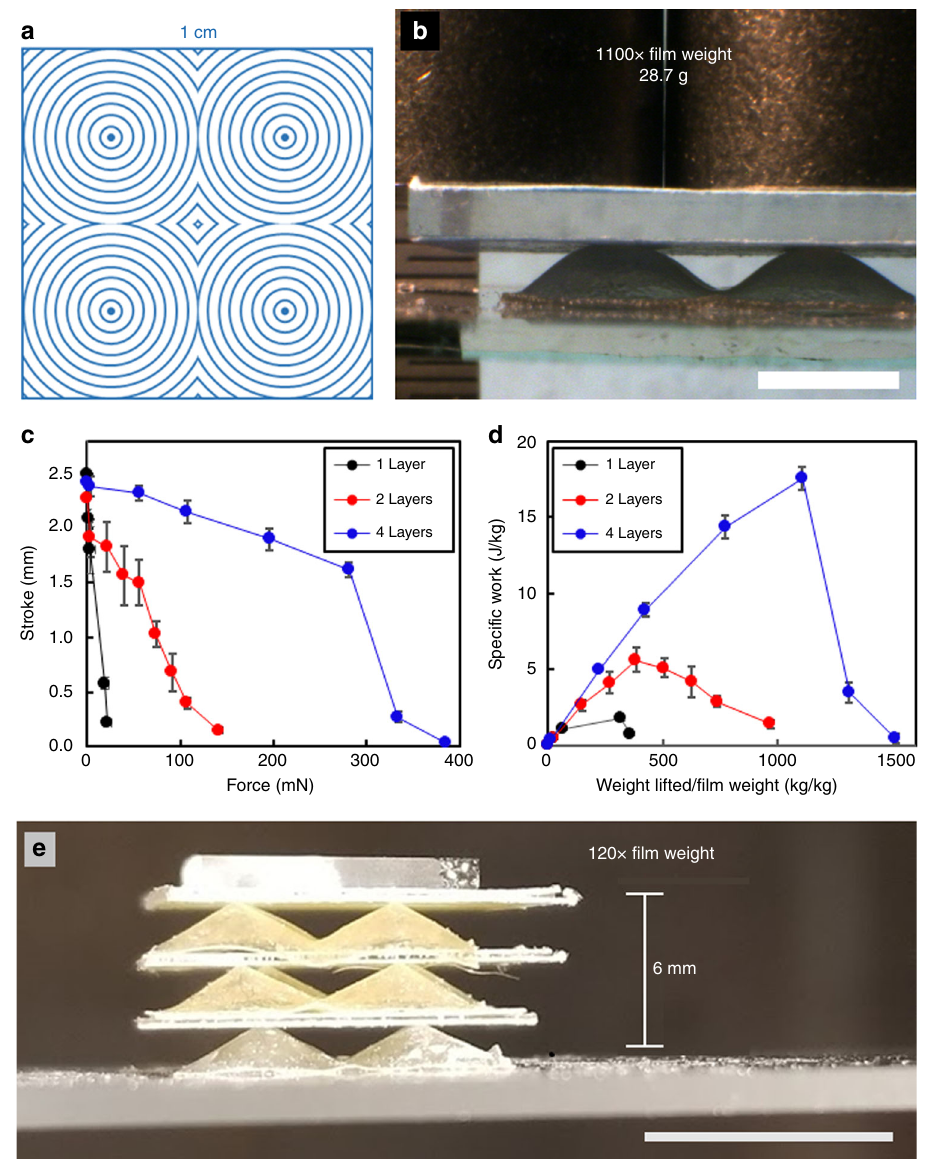
Fig. 2 Soft weightlifting. a Prescribed director pro fi le, to prepare a LCE fi lms with a 2 × 2 array of radial + 1 defects. b Deformation of a four layer LCE laminate lifting 28.7 g >2 mm. Scale bar is 3 mm. The LCE laminate was heated to 180 °C. c Stroke of LCE laminates under load. d The speci fi c work of the LCE laminates is contrasted against normalized weight. Error bars represent statistical experimental error. e Three 1 × 1 cm LCE fi lms are stacked with interfacing glass sheets, emulating a piezoelectric stack. A total of 1 g was lifted over 6 mm. Scale bar is 1